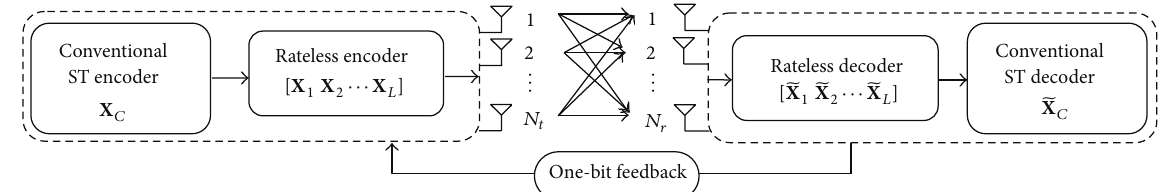
Figure 2: Sequential rateless space time block coded MIMO